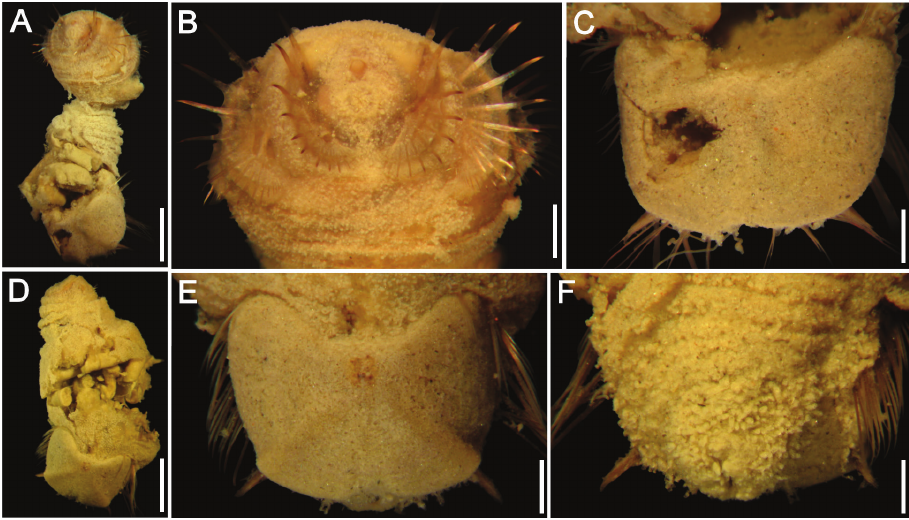
Figure 1. Caulleryaspis fauchaldi sp. n. A Holotype (LACM 5360), ventral view B Anterior end, frontal view C Ventro-caudal shield, frontal view D Paratype (LACM 5361), ventral view E Ventro-caudal shield, frontal view F Posterior end, dorsal view. Bars: A 1.8 mm B, C, E, F 0.6 mm D 2 mm.